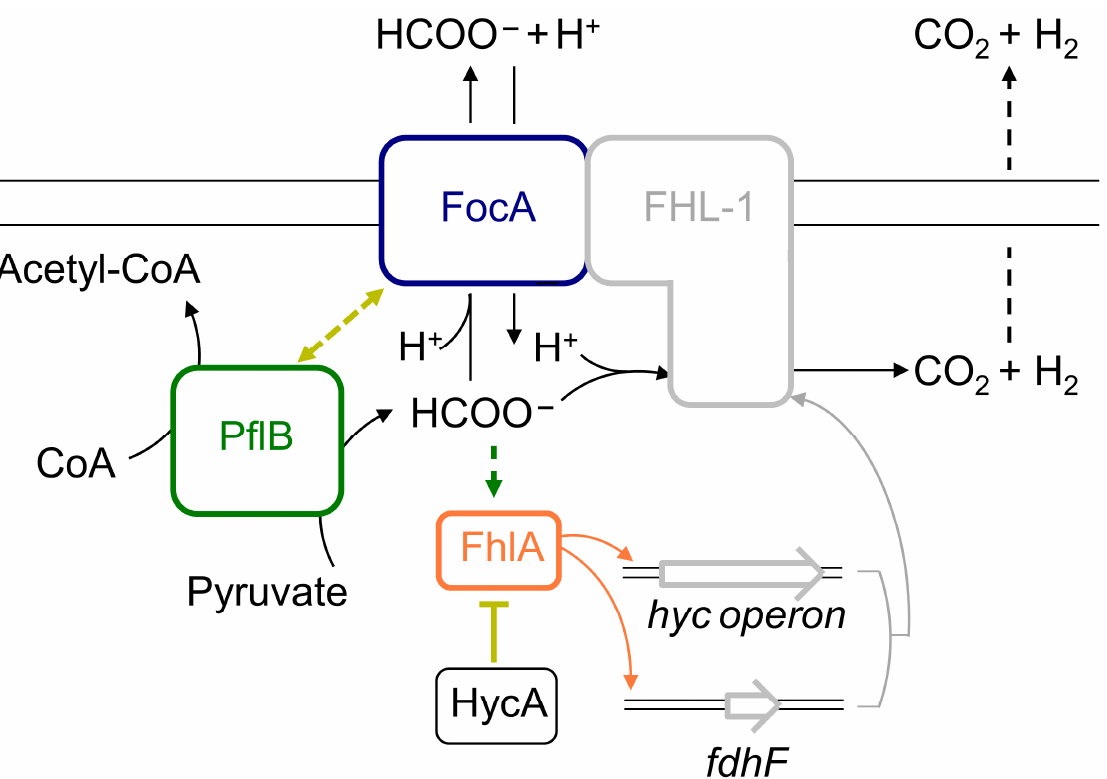
Figure 4. Model depicting how formate levels in E. coli are controlled during glucose fermentation. The cytoplasmic membrane is represented as parallel lines with the cytoplasm below the lines. Black straight or curved full lines represent conversions of metabolites; the dashed black line represents gaseous di ff usion across the membrane; light green lines represent regulatory protein interactions, with the arrowhead indicating a positive e ff ect and the bar a negative e ff ect; the dashed dark green line represents formate signalling; and the orange arrows indicate transcriptional activation. Abbre-